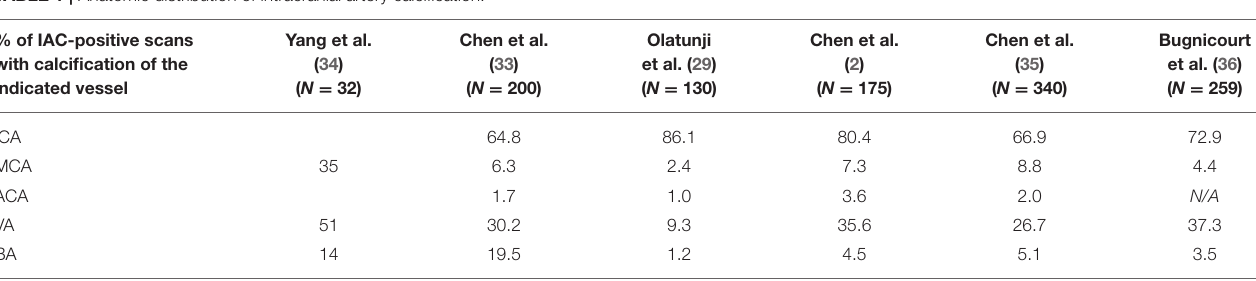
TABLE 1 | Anatomic distribution of intracranial artery